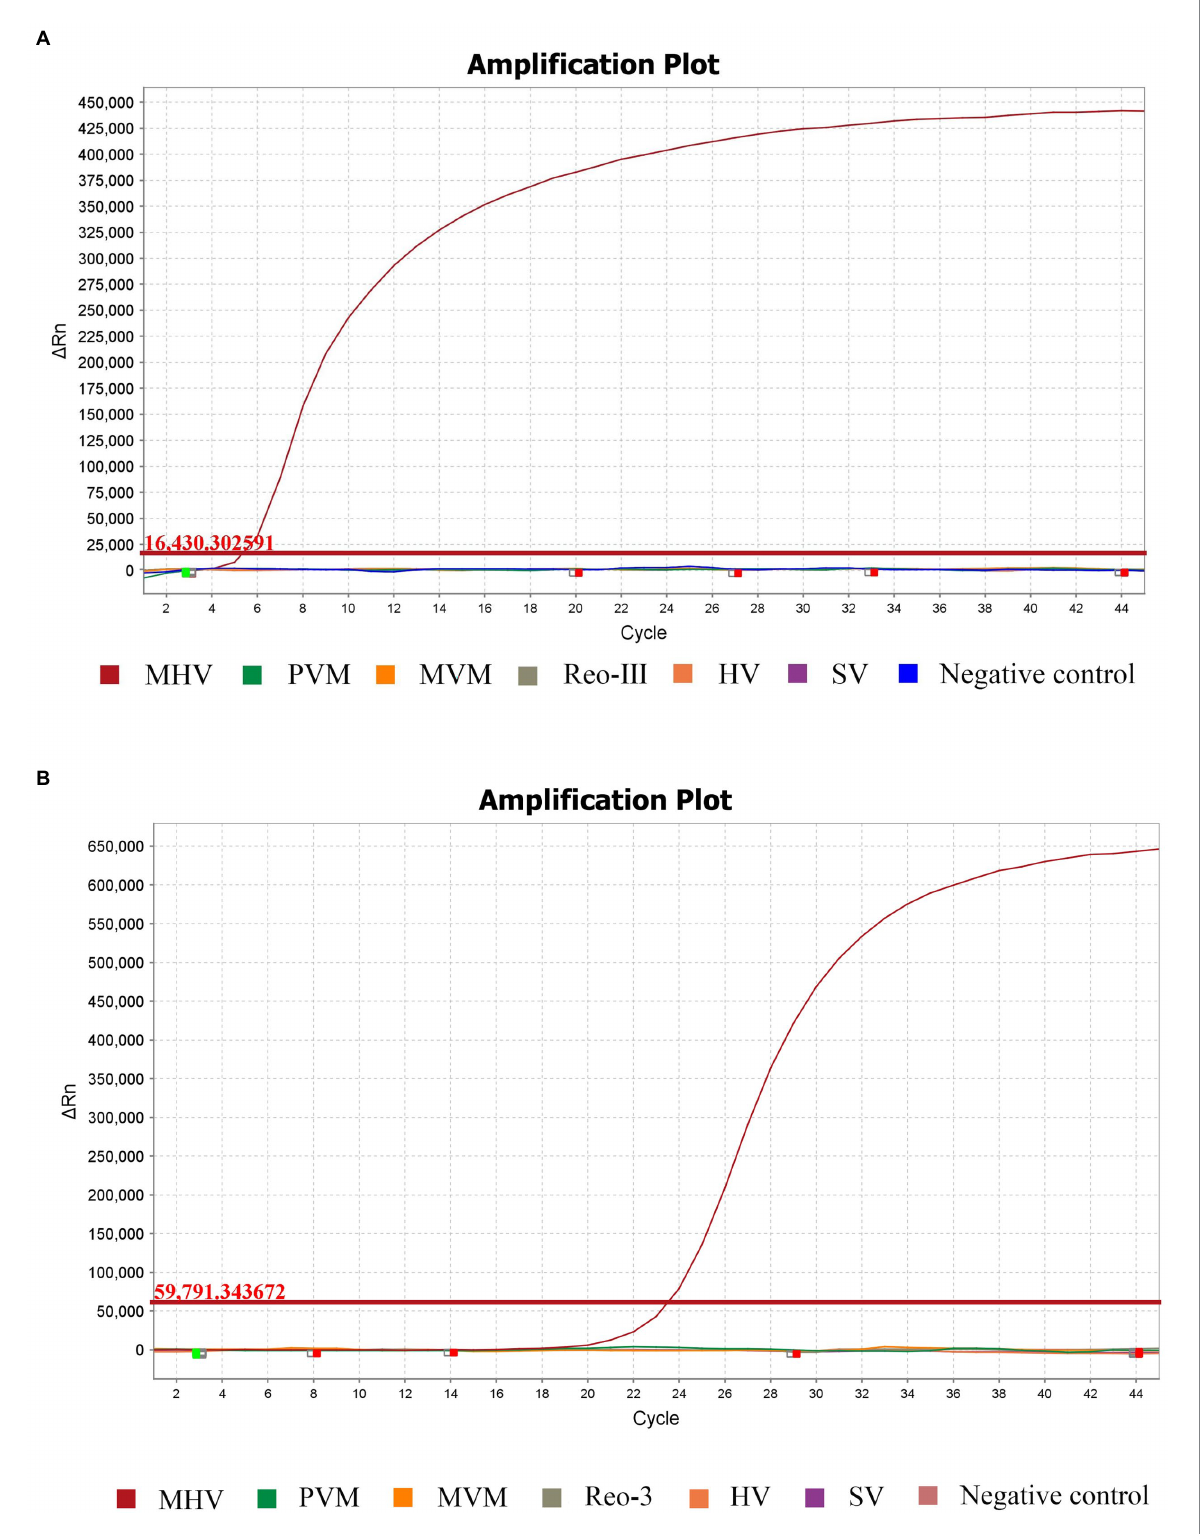
FIGURE 2 Specificity of the RPA method compared with the standard RT-qPCR. Analytical specificity of the RPA assay (A) . Specific fluorescence signal was observed from MHV, whereas no signals were obtained from other pathogens or the control. The same results occurred in RT-qPCR (B)